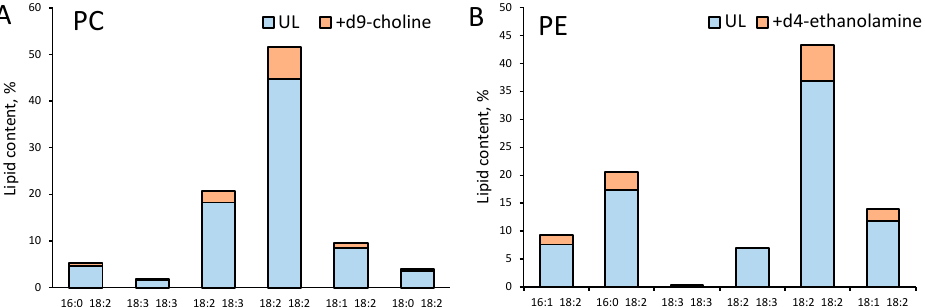
Figure 8. Incorporation of d9 -choline in PC ( A ) and d4 -ethanolamine in PE ( B ) molecular species in the middle zone of F. velutipes colony. Blue bars—unlabeled (UL) molecular species, orange bars— d9 -choline- or d4 -ethanolamine-labeled species.